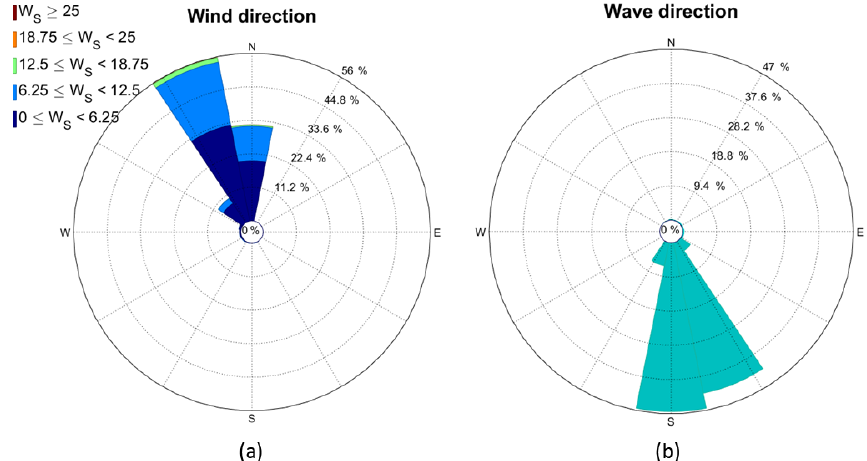
Figure A4. On the left side is the wind rose excluding the wind shadow zones at z = 18m, while on the right the peak wave direction is shown. Data correspond to the ASIT measurement mast during the 2003–2012 period only for wind opposing the wave